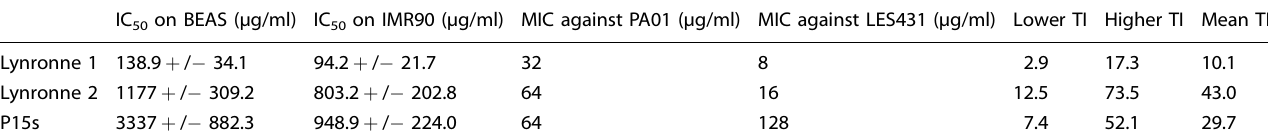
Table 2. AMP therapeutic indexes (TI): corresponding to the fold difference between IC 50 , with standard deviation ( + / − ).